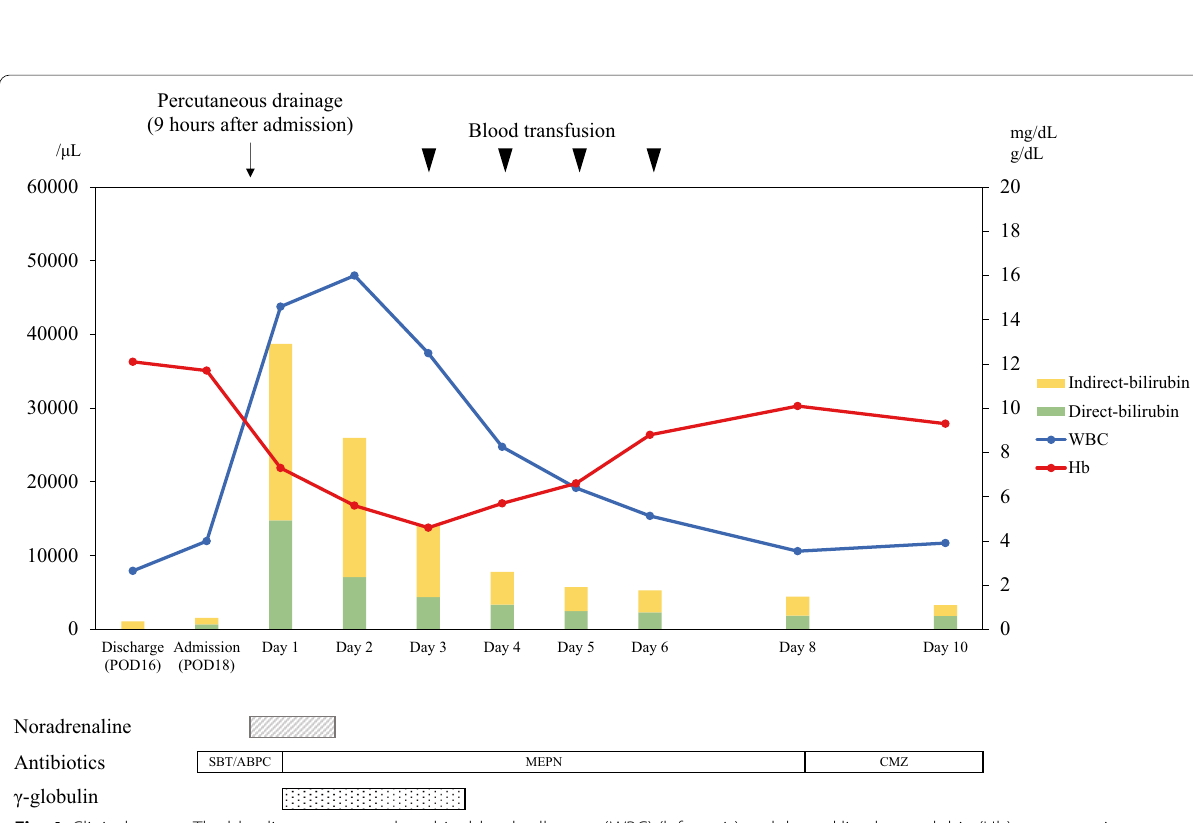
Fig. 4 Clinical course. The blue line represents the white blood cell count (WBC) (left y axis) and the red line hemoglobin (Hb) concentrations (right y -axis). The bar graph represents serum bilirubin concentrations (right y -axis). After drainage of the hepatic abscess, the patient’s vital signs improved dramatically. Blood tests showed improvements in inflammation-related variables and a decrease in bilirubin concentration. CMZ cefmetazole, MEPN meropenem, SBT/ABPC